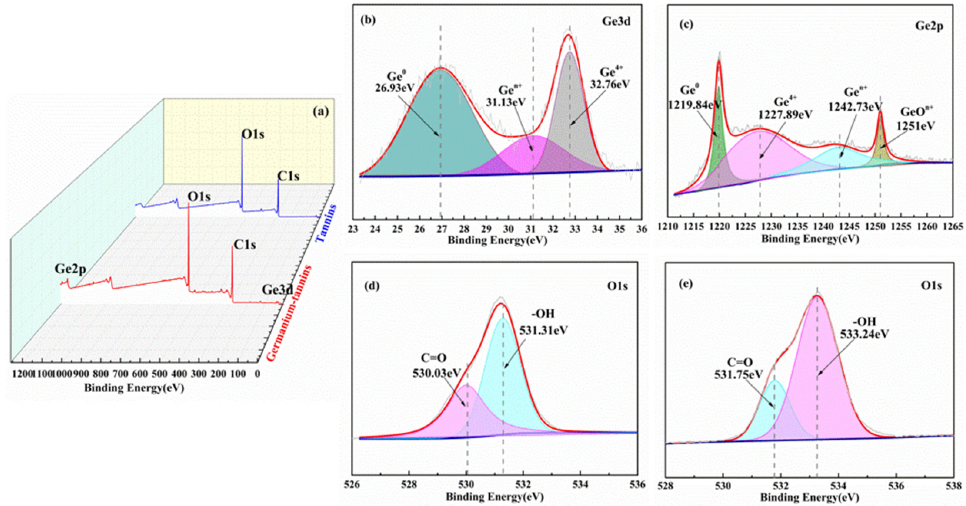
Figure 6. Full-scan spectrum ( a ) and Ge 3d spectrum ( b ); Ge 2p spectrum ( c ), O 1s spectrum ( d , e ) of tannins and tannins and germanium–tannins.